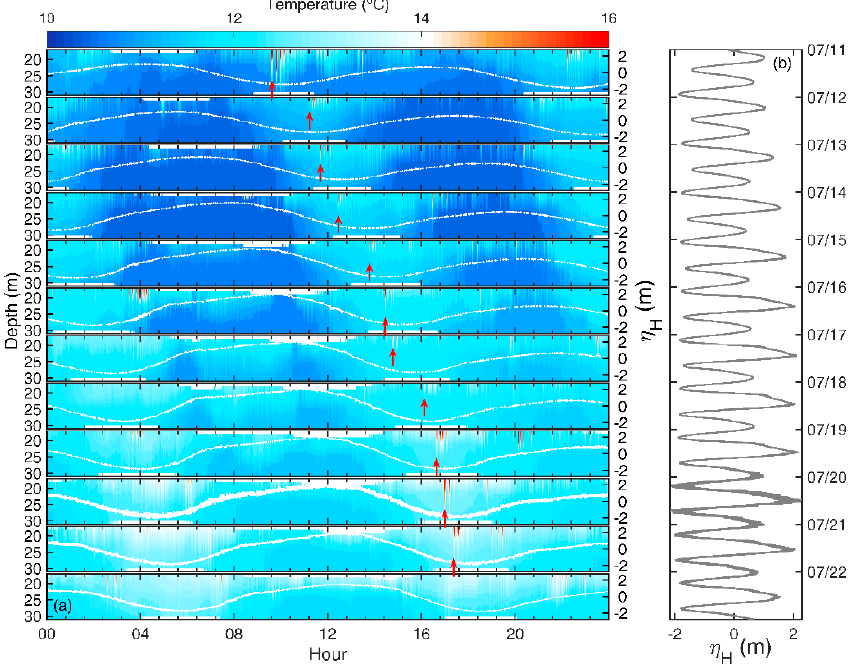
Figure 9. ( a ) Stack plots of the temperature at Stn. B4 from 11 − 22 July 2019 (UTC + 8). Red arrows indicate the arrival times of the ISW packets, and the white line indicates the surface elevation. ( b ) The corresponding time series of the barotropic tide at Stn. B4.